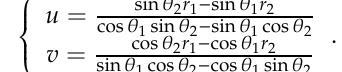
P L P R as the rotation axis X med ,